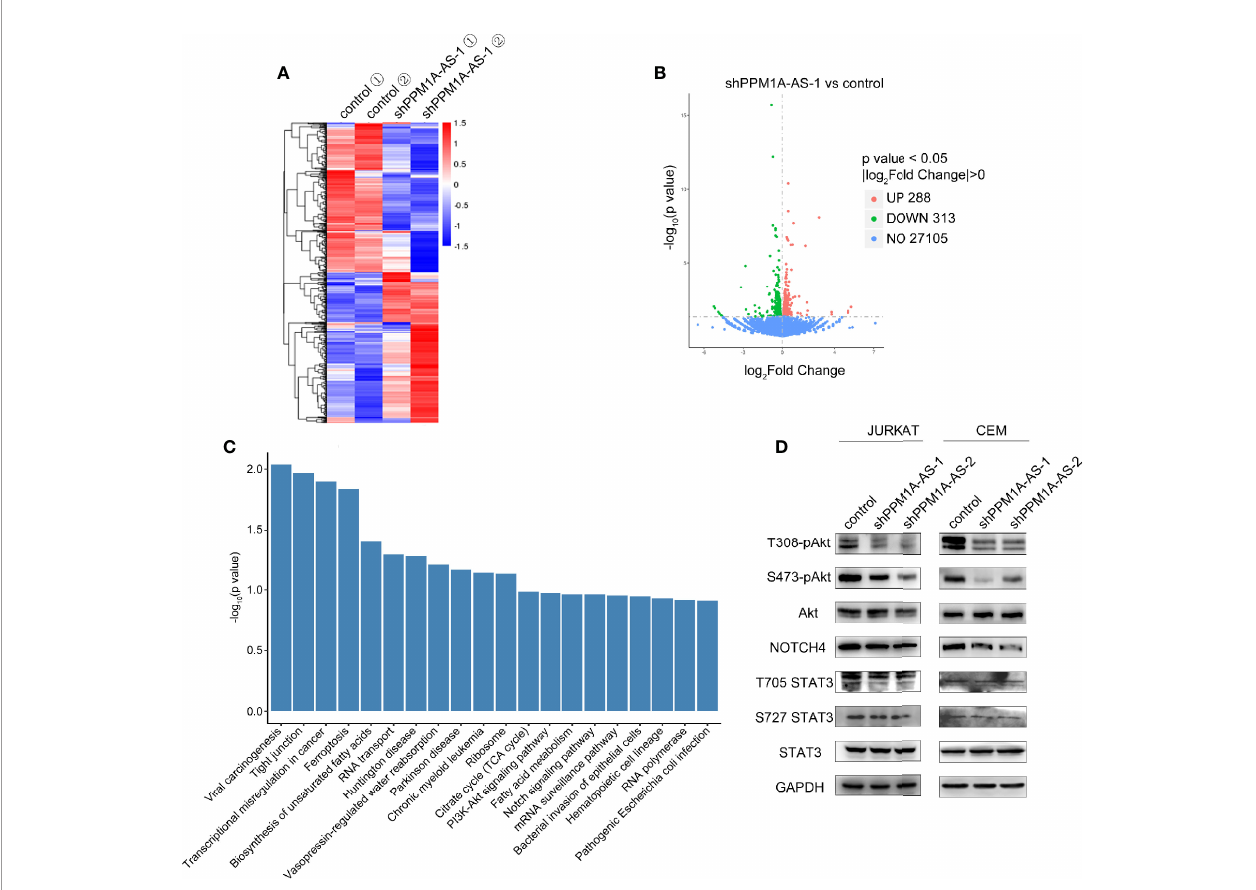
FIGURE 5 | LncRNA PPM1A-AS regulates multiple signaling pathways in T-ALL. (A) The heatmap of transcriptome sequencing of Jurkat cells infected with control or PPM1A-AS-knockdown lentivirus. (B) The volcano plot representation of differentially expressed mRNAs upon PPM1A-AS knockdown. (C) Signi fi cantly enriched pathways relative to differentially expressed mRNAs upon PPM1A-AS knockdown. (D) Western blot analysis of core proteins belonging to T-ALL relative signaling